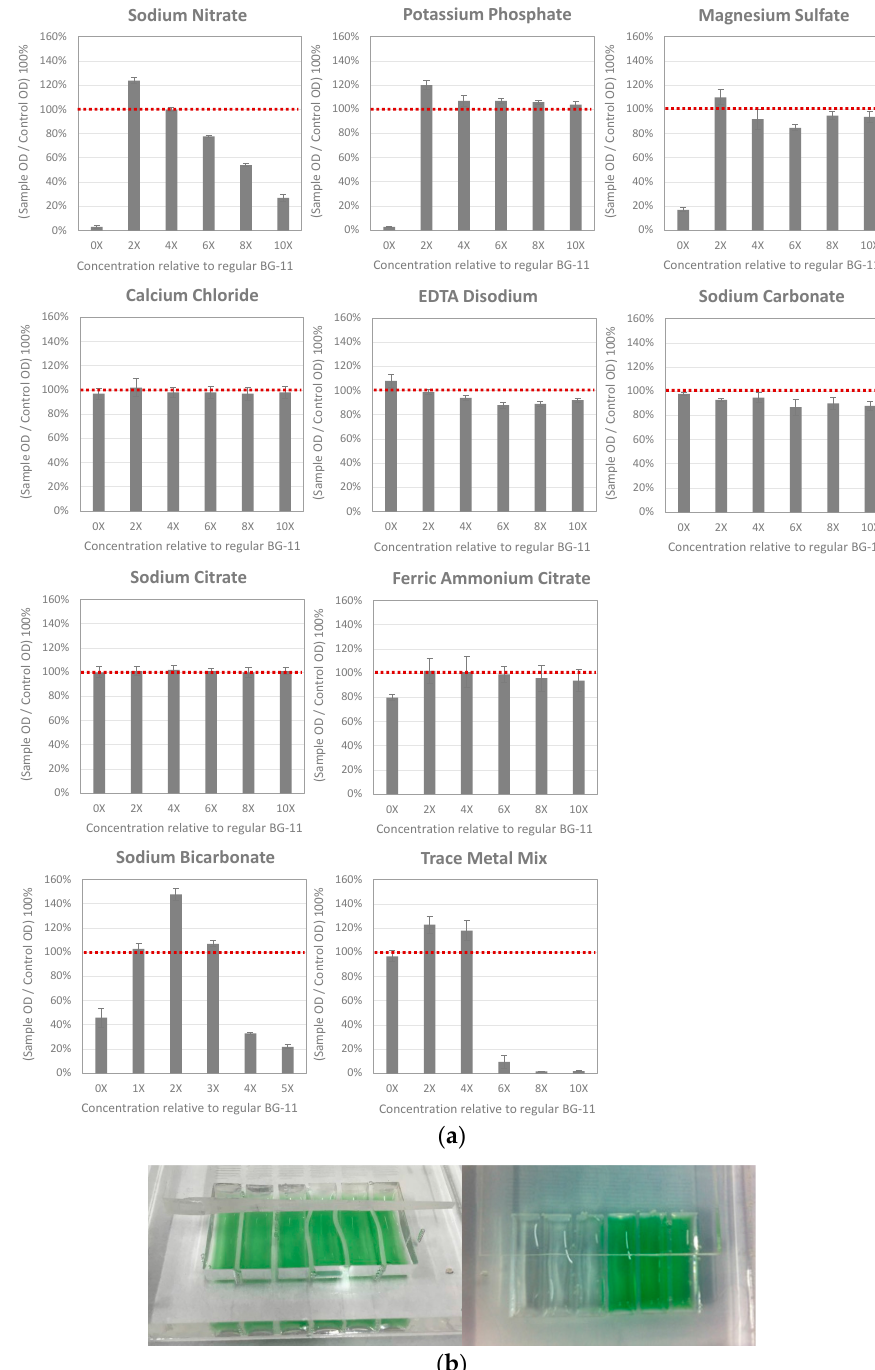
Figure 3. ( a ) Cyanobacteria growth comparison cultivated with different BG-11 medium composition in the microfluidic device for 72 h. Chart title indicates the specific medium component of which the concentration was varied as shown by the x -axis relative to the amount used in the regular BG-11 medium (Table 1). The y -axis represents the % increase or decrease in cell density compared to the “control”, which was cultivated under regular BG-11 medium. Standard deviation was calculated based on three repeats for the group grown under modified media. An average cell density of OD 730 = 1.12 ± 0.1 was obtained for the “control” group by averaging cell densities across all six cultivation chambers with many repeats. ( b ) Example illustration of cyanobacteria growth in the microfluidic cultivation chamber after 72 h. Left: control group grown in regular BG-11 medium across all six chambers. Right: test group grown with different concentrations of trace metal mix in the order of 10X, 8X, 6X, 4X, 2X, to 0X going from left to right.